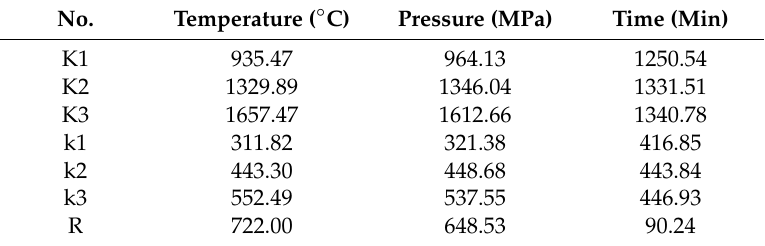
Table 3. Result of Taguchi method (TM) orthogonal